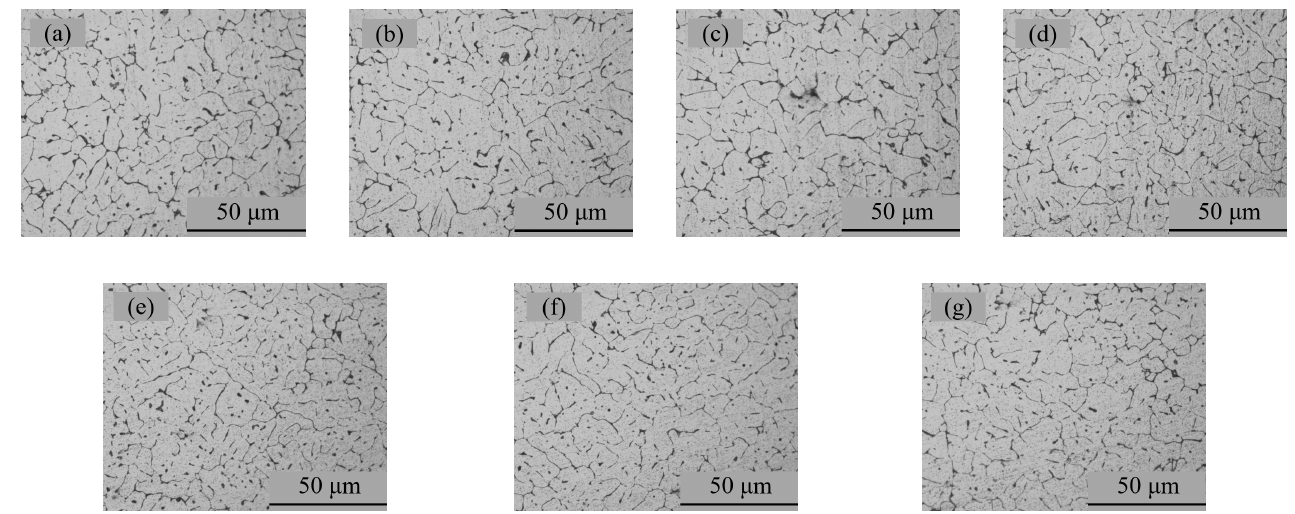
Figure 7. Microstructure photograph of the metallographic samples: ( a ) specimen A01; ( b ) speci- men A02; ( c ) specimen A03; ( d ) specimen A04; ( e ) specimen A05; ( f ) specimen A06; ( g ) specimen A07.